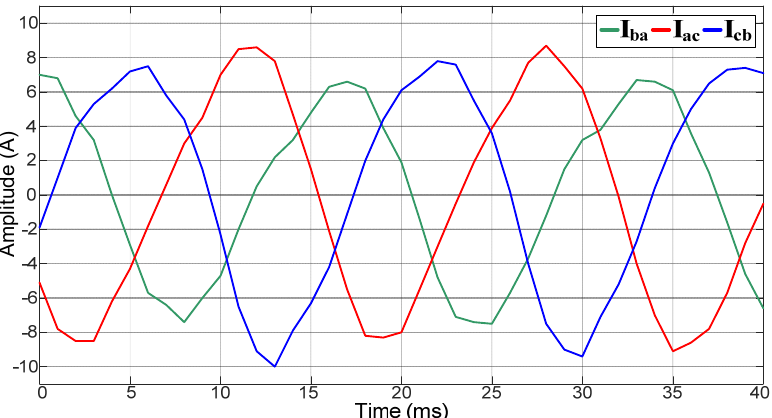
Figure 12. Line currents from an induction motor with a 12% short-circuit fault condition on phase-C of its stator winding.